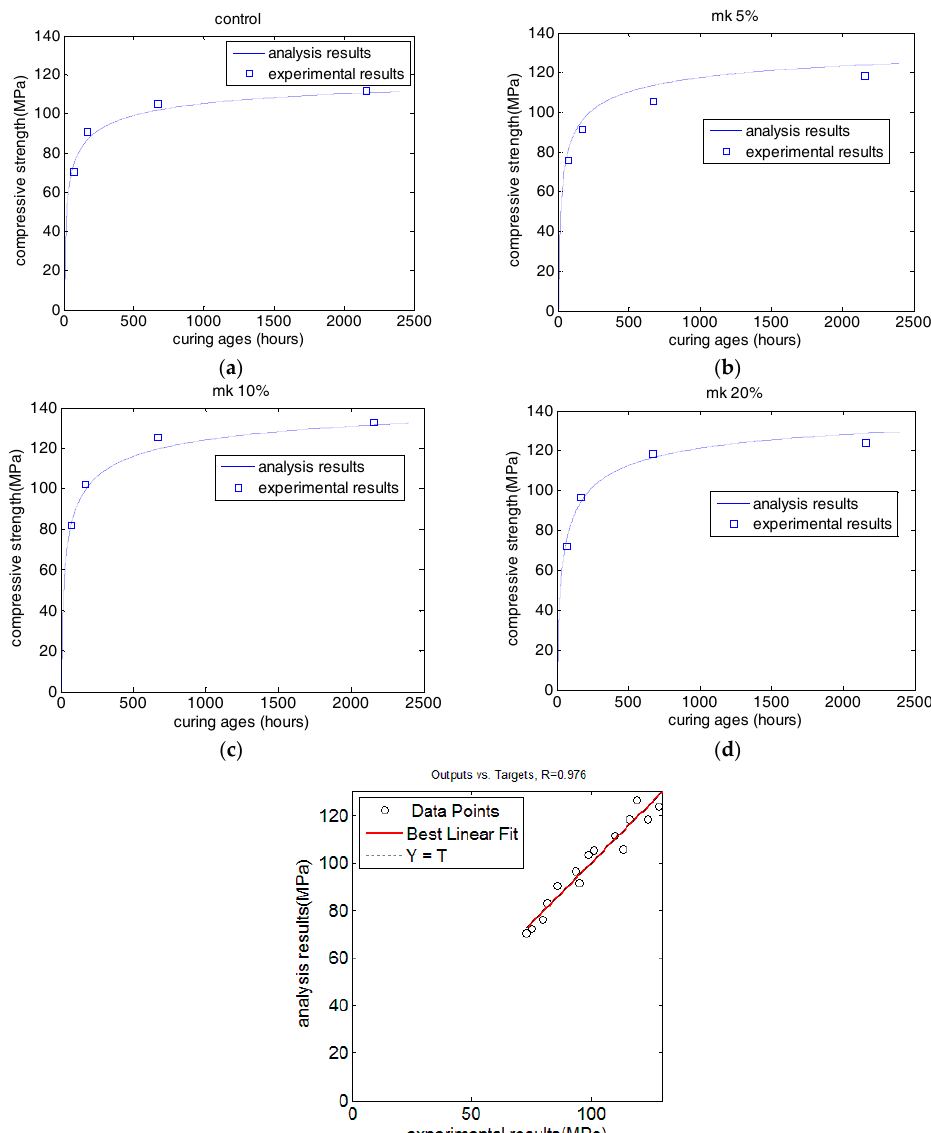
Figure 5. Strength development of cement-MK paste. ( a ) control; ( b ) MK 5%; ( c ) MK 10%; ( d ) MK 20%; and ( e ) comparison between the analysis and experimental results (W/B = 0.3).